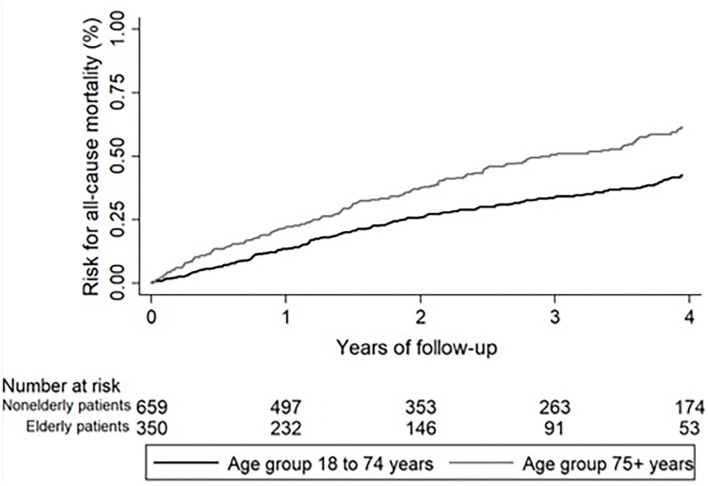
All-cause mortality over 4 years in patients with IPF. All-cause mortality was significantly higher in elderly (black line) compared to nonelderly patients with IPF (gray line). IPF, idiopathic pulmonary fibrosis.